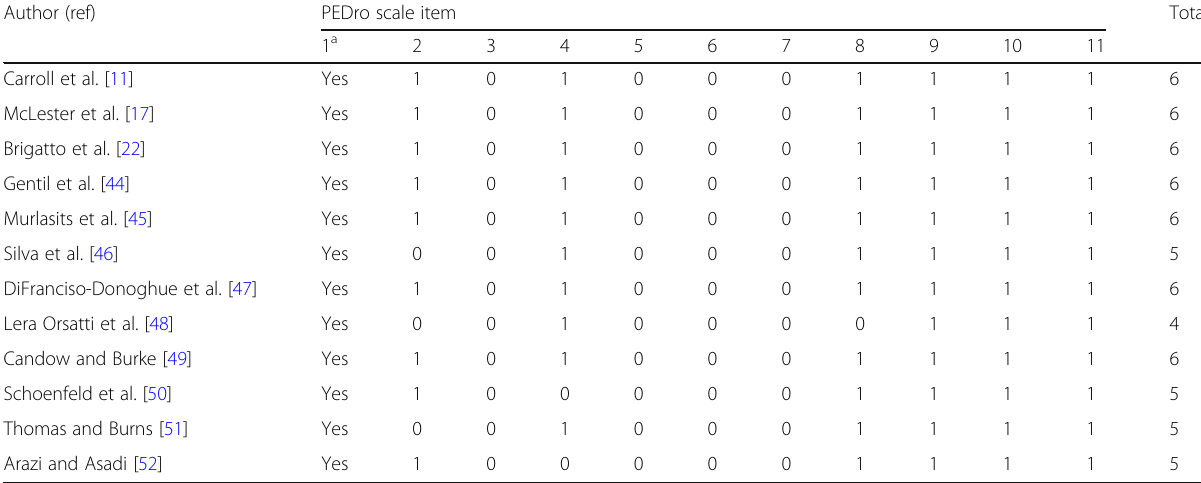
Table 2 Methodological quality of studies based on the PEDro score Author